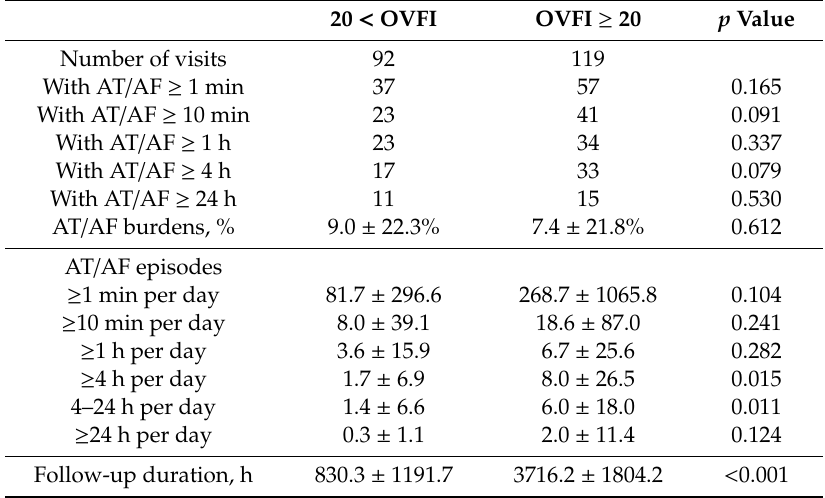
Table 4. AT / AF burden, incidence, and follow-up duration in the two OVFI groups.